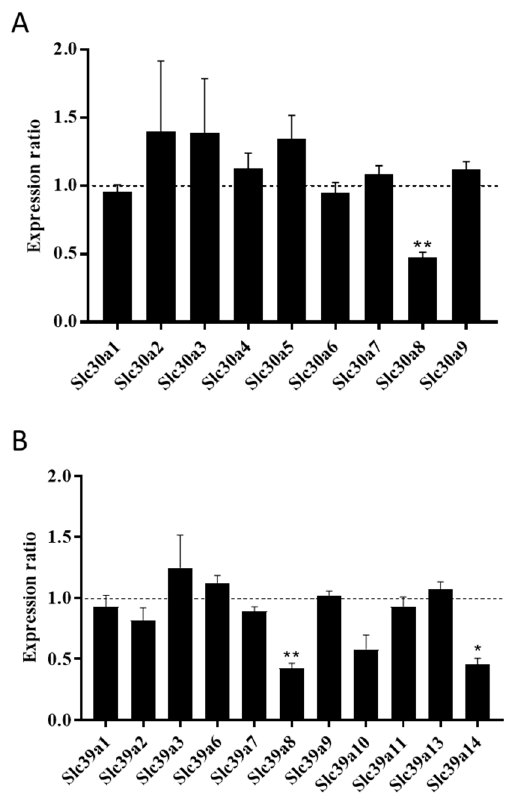
Figure 2. Zinc transporter expression in ZnT8 haploinsufficient MIN6 cells. The graphs show mRNA expression for ( A ) Slc30a and ( B ) Slc39a paralogues in ZnT8 haploinsufficient MIN6 cells generated by CRISPR/Cas9 technology. We were unable to detect quantifiable expression for Slc30a10, Slc39a4, Slc39a5 or Slc39a12 . Changes in mRNA expression were measured by qPCR and are presented as the ratio relative to the expression level in sham-CRISPR MIN6 cells (control), which is indicated by the dotted line. Experiments were carried out at 48 h. Data were analysed through t -tests and corrected for multiple comparisons. Error bars show ±SEM. n = 3. * p < 0.05, ** p < 0.005.